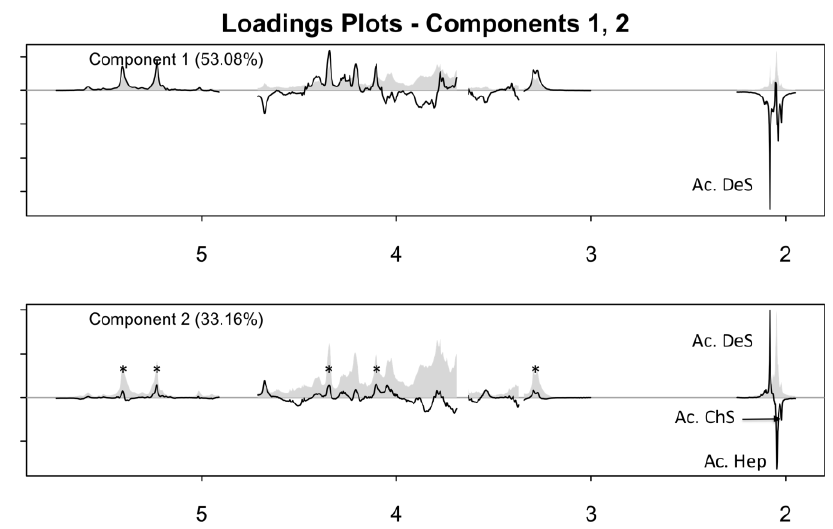
Figure 3. Loading plot of the first two components of the PCA of the GAGs signals region. In the loading plot of component 1, a negative signal corresponding to the N -acetyl residue of dermatan is observed. Positive signals corresponding to the trisulfated disaccharide (*) (-I2S-GlcNS,6S-) and negative signals corresponding to the N -acetyl residue of glucosamine (Hep) and galatosamine (ChS) are observed in the loading plot of component 2.